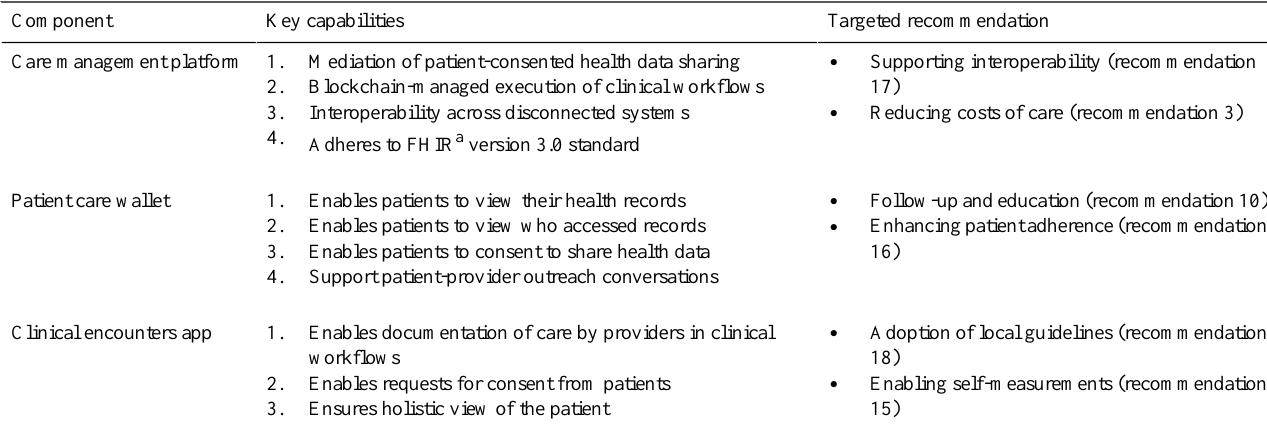
Table 3. Key components and capabilities of the proposed digital health wallet